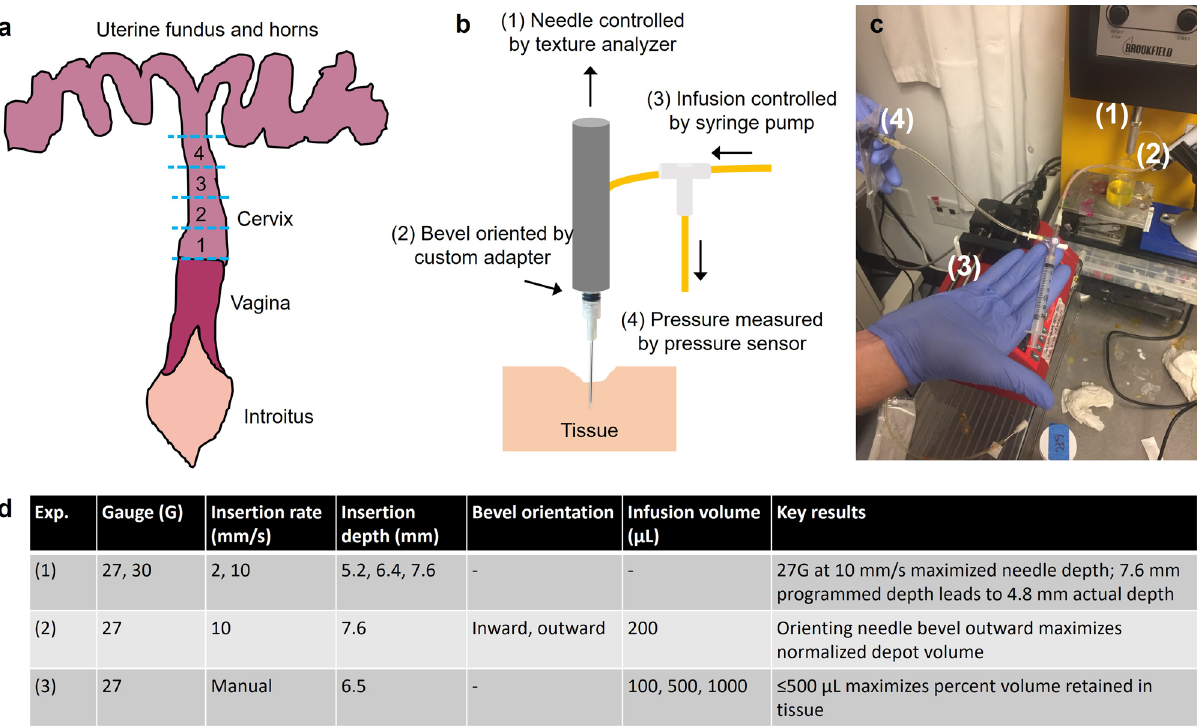
Figure 7. Ex vivo swine cervix experimental methodology. ( a ) The swine cervix was located within the excised reproductive tract and then sectioned transversely into approximately 4 equal pieces for experiments. ( b ) Schematic and ( c ) photograph of benchtop system, which contains (1) needle attached via a custom adapter to the Texture Analyzer to control needle insertion rate and depth. (2) The orientation of the needle bevel can be controlled through how it is attached to the custom adapter. The needle is also connected to a 3-way Luer Lok valve via tubing. The other openings from the Luer Lok are connected to (3) syringe loaded into a syringe pump to control infusion rate and volume and (4) pressure sensor to monitor pressure throughout the injection. ( d ) Summary of ex vivo swine cervix experiments with the benchtop system and key parameters that were varied in each